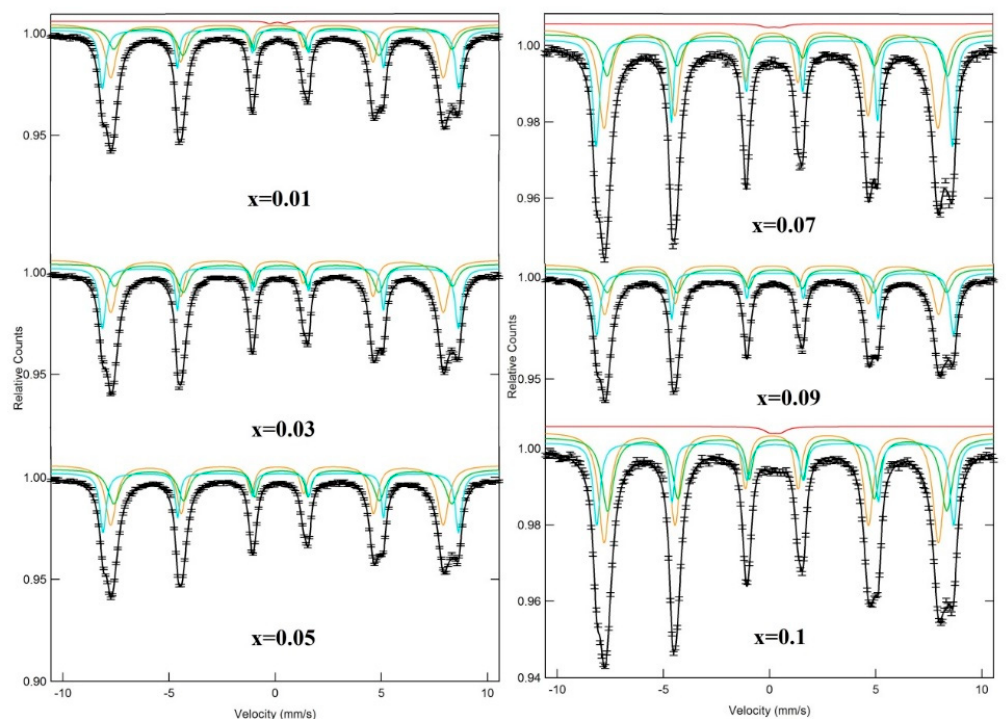
Figure 4. Mössbauer spectra of studied NPs.